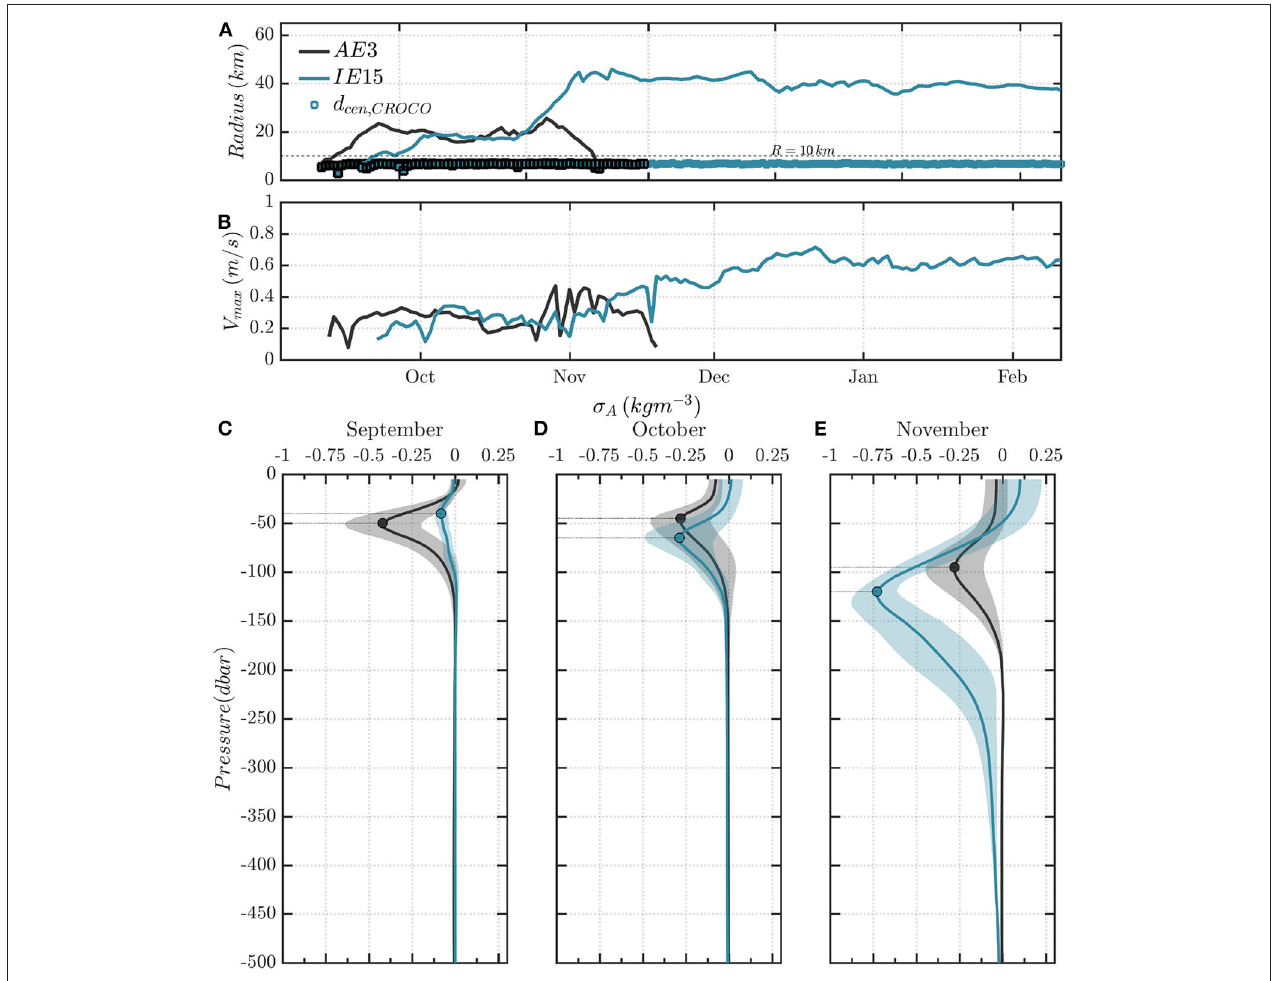
FIGURE 9 | Temporal evolution of dynamical characteristics of (A) velocity V max ( m / s ) and (B) radius R max ( km ) for the coastal eddies AE3 and M_IE15 as computed with AMEDA algorithm applied on CROCO geostrophic fields. Comparison between the vertical profiles of density anomaly σ A ( kgm − 3 ) are shown for the months of (C) September 2015, (D) October 2015, and (E) November 2015 for the two anticyclones AE3 and M_IE15 from the CROCO-MED60v40-2015